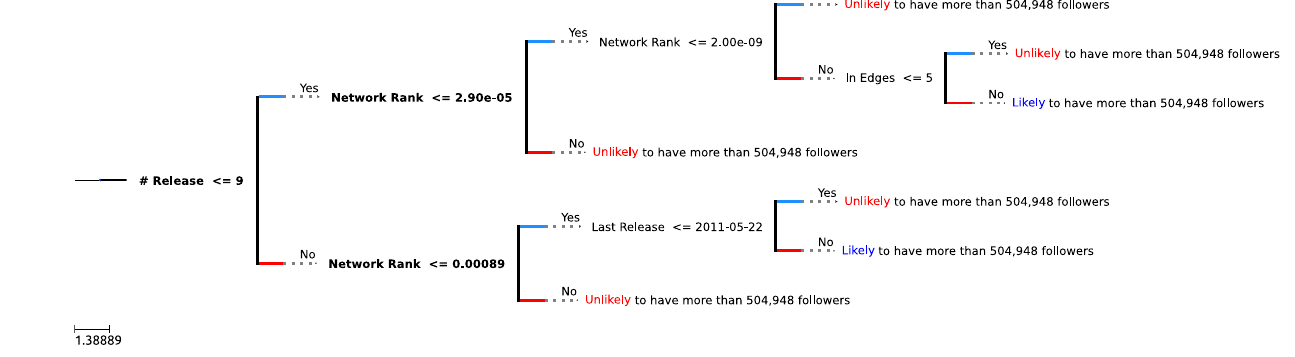
Figure 5. A Visualization of XGBoost tree classifying follower count >